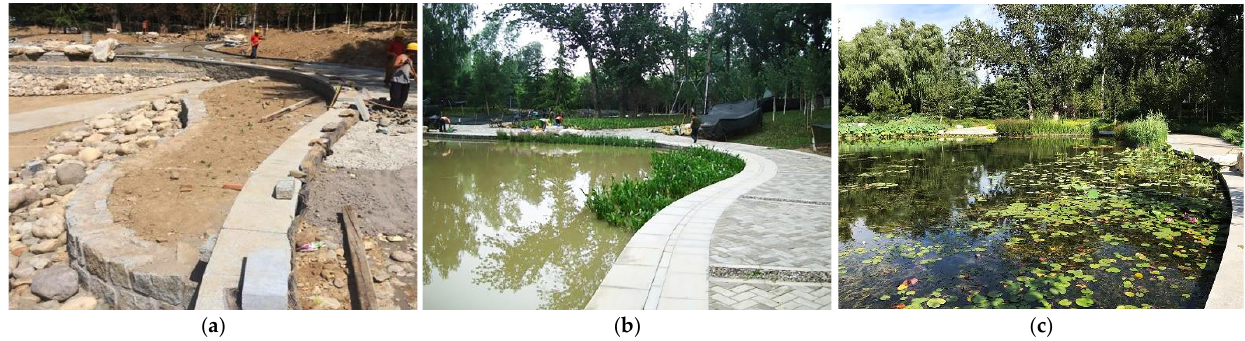
Figure A2. ( a ) Construction of “multilevel” revetments and lakebeds at pond 4; ( b ) aquatic macro- phytes were planted in the “multilevel” pond revetments and lakebeds of pond 4, forming a “mul- tilayer” plant configuration in the second experimental year, and the water quality was relatively poor in the initial stage of remediation; ( c ) aquatic macrophytes grew well, and the water quality was greatly improved in the third experimental year.